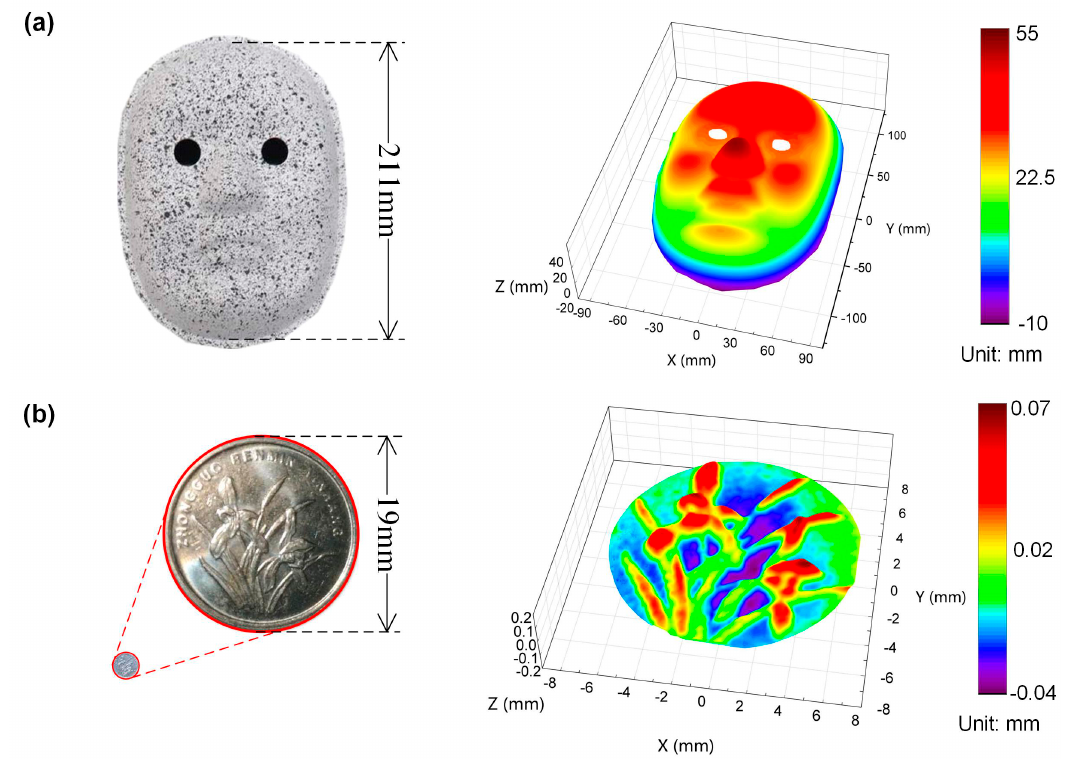
Figure 6. Photographs and reconstructed profiles of ( a ) a human face model and ( b ) a 1-jiao coin.